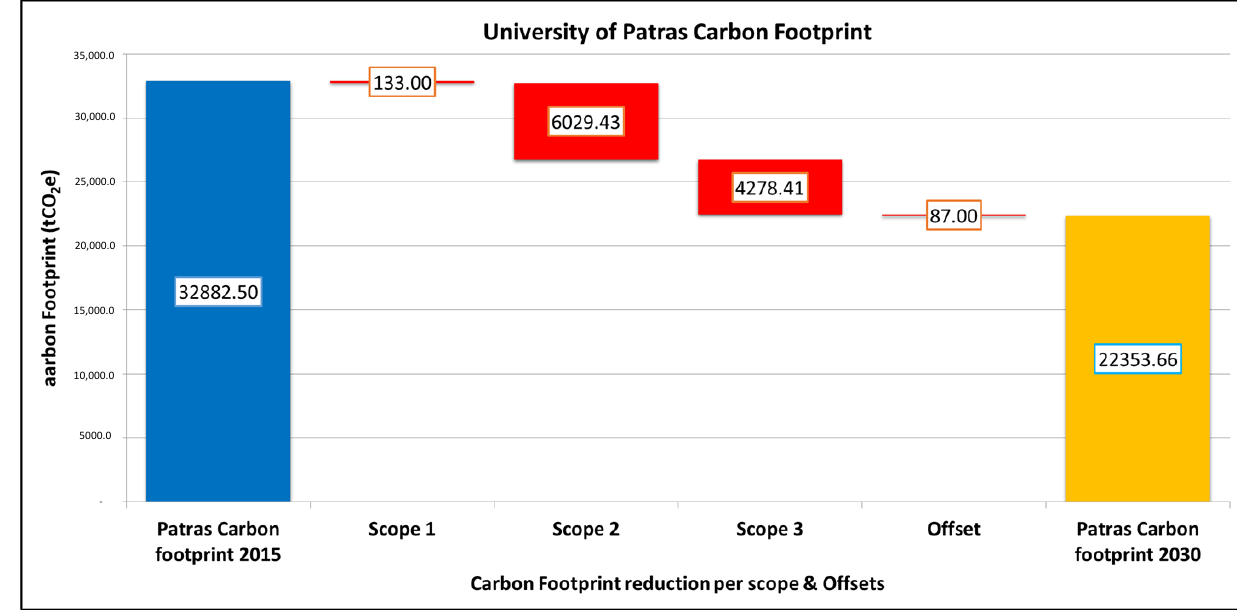
Figure 6. Waterfall diagram per scope. Table 3. University of Patras Action Plan for carbon footprint